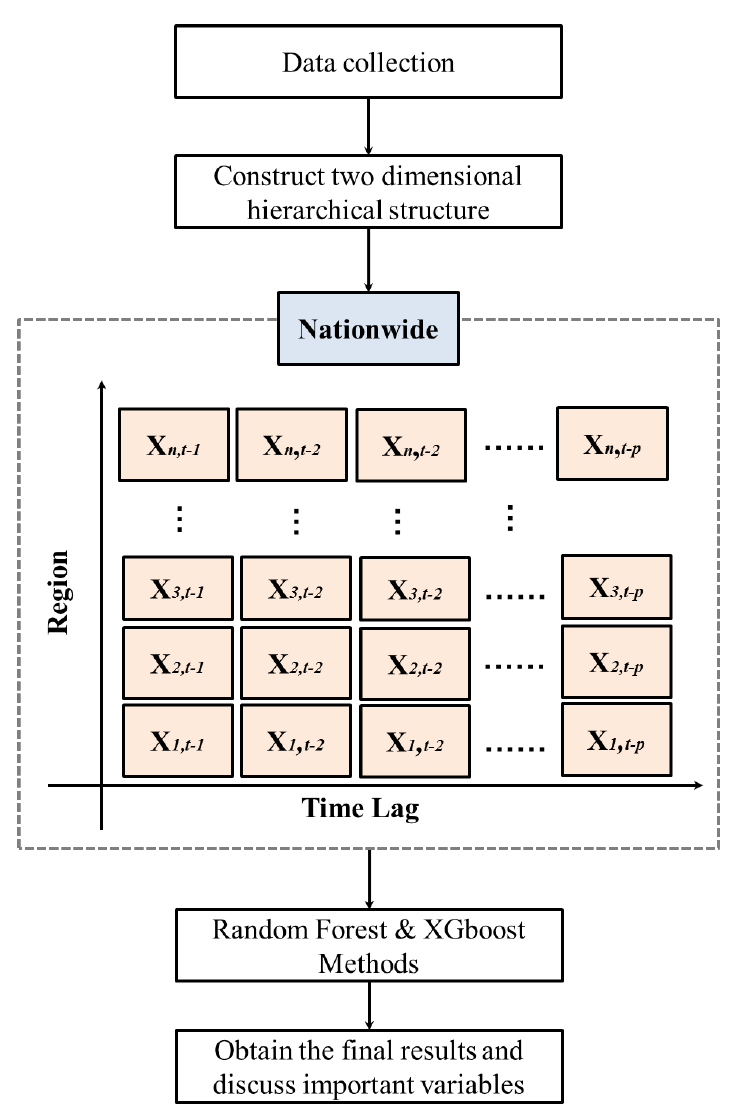
Figure 1. The flowchart of the proposed influenza outpatient visits forecasting scheme.